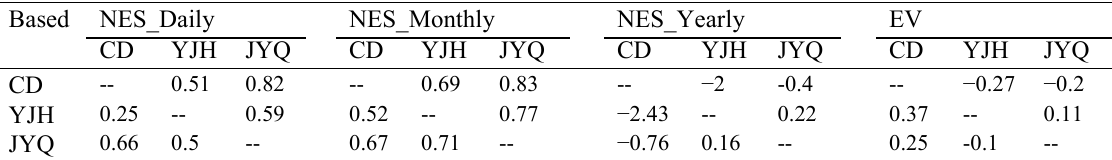
Table 3 The Nash-Sutcliffe efficiency coefficient (NSE) of discharge for CD, YJH and JYQ obtained by using the disaggregation method based on the discharge at one of CD, YJH and JYQ at daily, monthly and yearly scale. The last three columns are for EV, the values of which are the same at three scales.